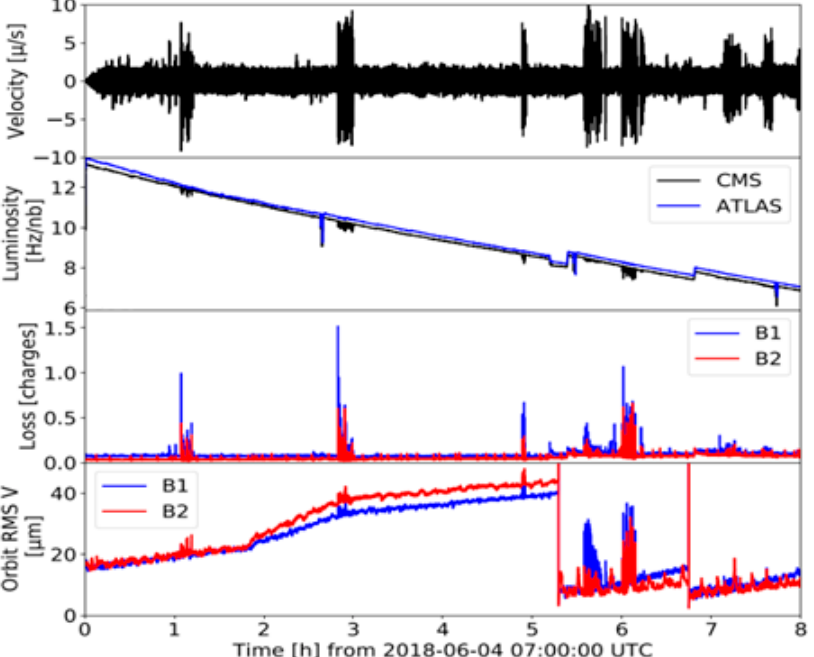
Figure 6. Top row: seismic motion in IP5 and beam development on Fill 6757 (4 June 2018); ATLAS and CMS live luminosity, calibrated losses, vertical RMS orbit (second to fourth row). During the earthquake swarm event, it was not possible to see the effect on the beam due to the service shutdown of the experiments (so-called Long Showdown 2). However, is connected to visual effects on the beam data) it is known which events, in normal con-